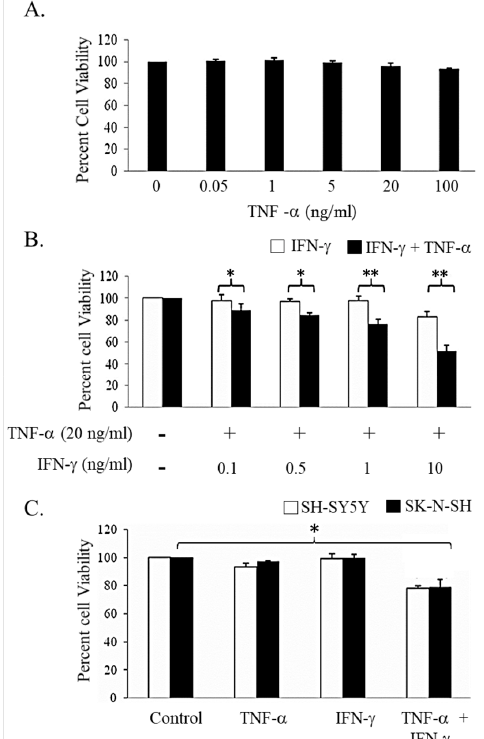
Figure 1. Dose-dependent effect of Interferon-gamma (IFN- γ ) and Tumor necrosis factor-alpha (TNF- α ) alone or in combination treatment on neuroblastoma cell lines. SK-N-MC cells were treated for 48 h with increasing concentrations of ( A ) TNF- α ; and (B) IFN- γ alone and in combination and the viability was quantified by 3-(4,5-dimethylthiazol-2-yl)-2,5-diphenyltetrazolium bromide (MTT) assay. The effect of combination treatment was tested on other Neuroblastoma cell lines; SH-SY-5Y and SK-N-SH (C). Cells were treated with TNF- α (20 ng/mL) and IFN- γ (10 ng/mL) alone and in combination for 48 h and the viable cells were quantified by MTT assay. The data represented is the mean ± standard error of mean ( n = 5). * p < 0.05; ** p < 0.005. − : untreated; +: